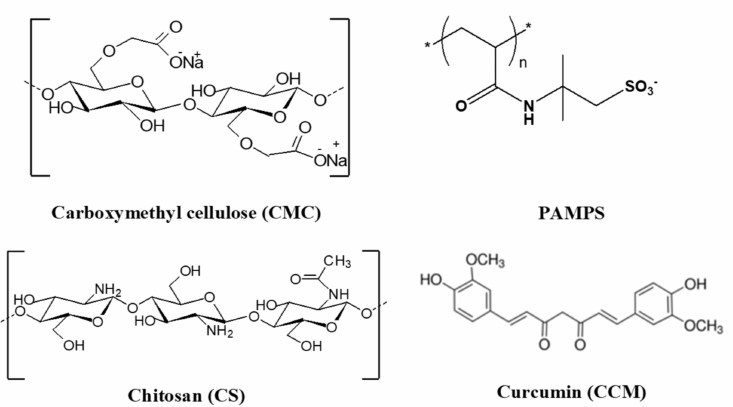
Figure 1. Molecular structures of polyelectrolytes used in the PECs formation and of curcumin used to test performances of PEC cryogels in controlled delivery of drugs.